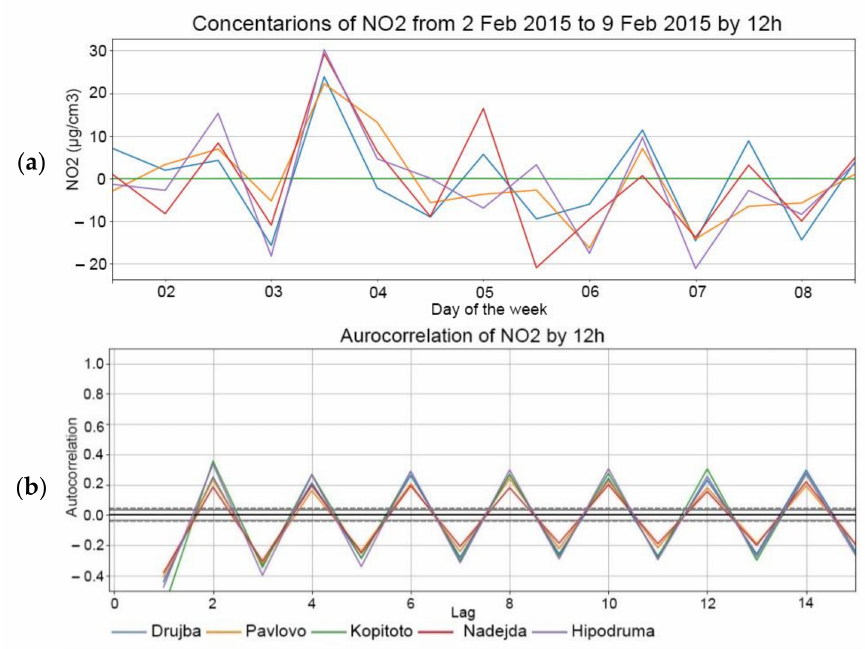
Figure 11. The signal for the different stations corresponding to NO 2 for granularity 12 h with lag difference 1 ( a ) and its autocorrelation ( b